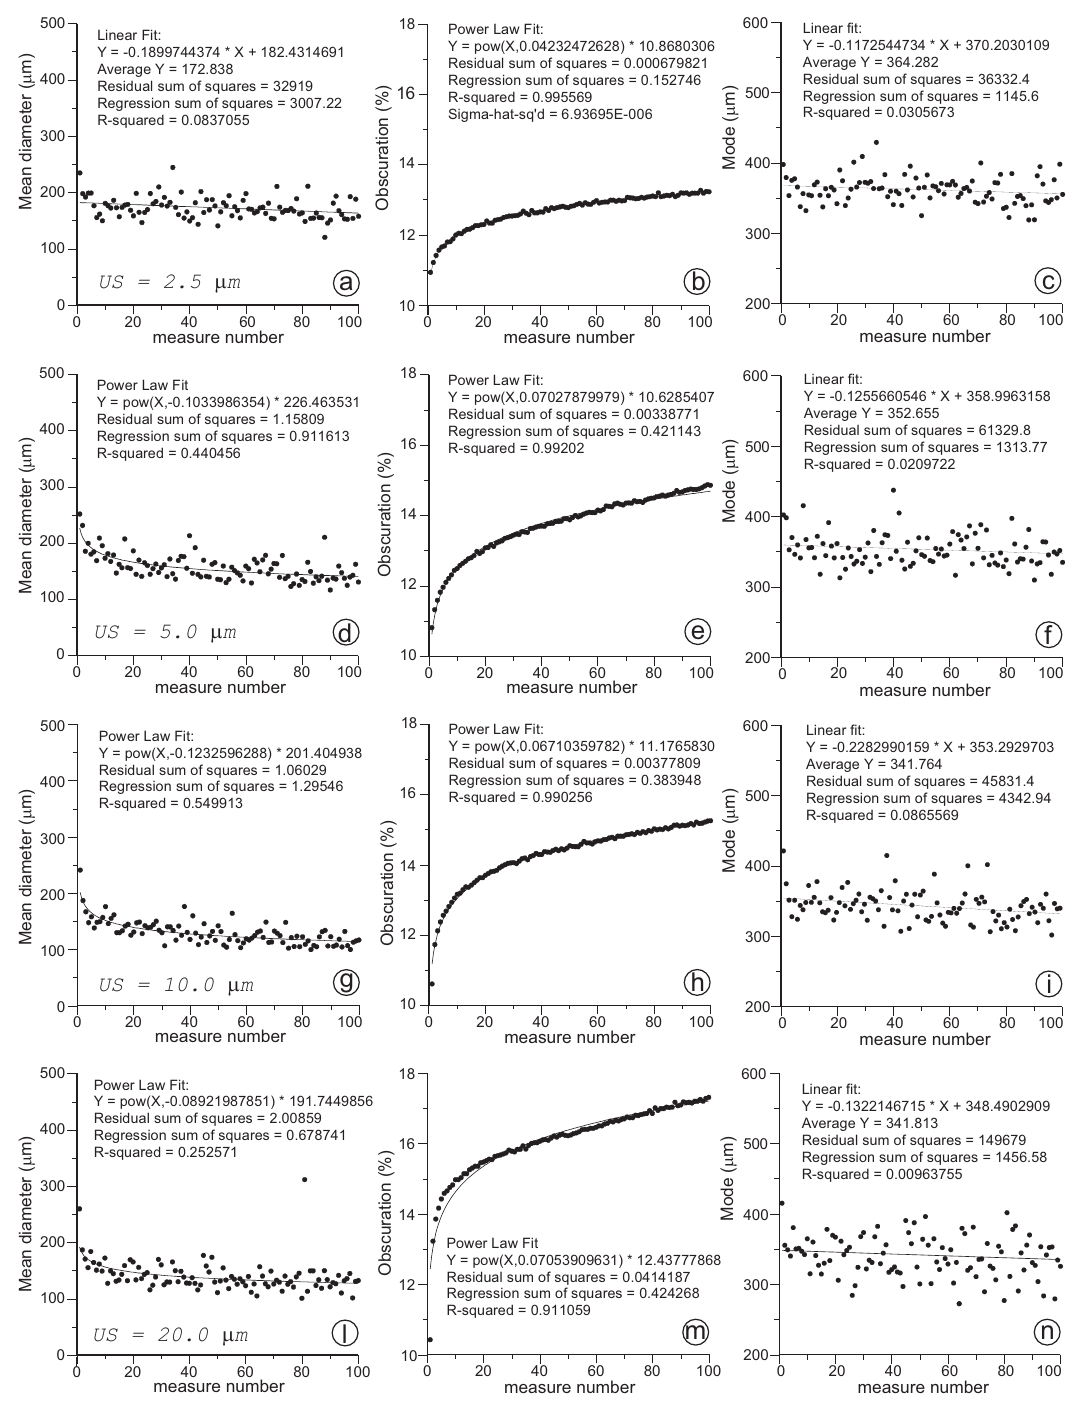
Fig. 16. Ultrasonication tests on sample CABRE3 by the Hydro 2000 MU dispersion unit. (a) Ultrasonication test US2 . 5 5 performed on sub-sample aliquot CABRE3l; mean diameter value evolution with increasing the number of measurement runs. (b) Laser obscuration value progression during the same test. (c) Mode value progression during the same test. (d) Ultrasonication test US5 5 performed on sub-sample aliquot CABRE3m; mean diameter value evolution with increasing the number of measurement runs. (e) Laser obscuration value progression during the same test. (f) Mode value progression during the same test. (g) Ultrasonication test US10 5 performed on sub-sample aliquot CABRE3n; mean diameter value evolution with increasing the number of measurement runs. (h) Laser obscuration value progression during the same test. (i) Mode value progression during the same test. (l) Ultrasonication test US20 5 performed on sub-sample aliquot CABRE3o; mean diameter value evolution with increasing the number of measurement runs. (m) Laser obscuration value progression during the same test. (n) Mode value progression during the same test. Data statistics are provided for all